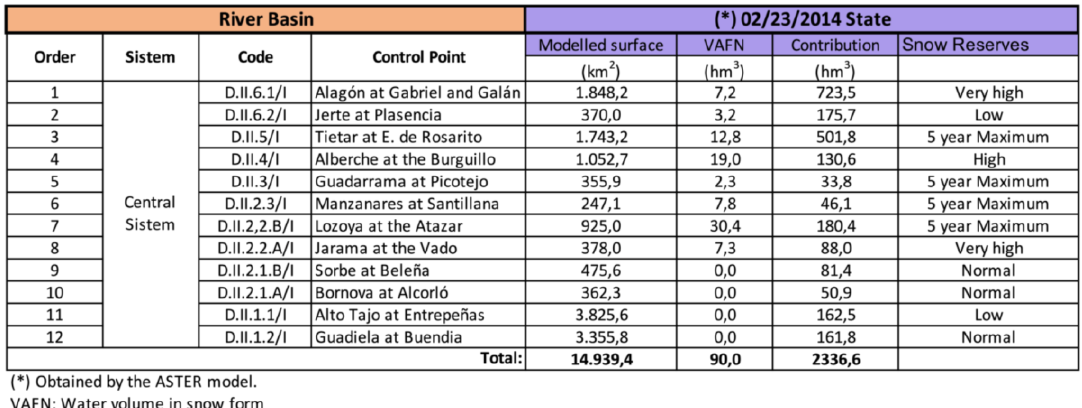
Water 2020 , 12 , x FOR PEER REVIEW Figure 5. Exampleofmonthlysnowreport(ERHIN)intheTagusBasin(TagusHydrographicConfederation). Figure 5. Example of monthly snow report (ERHIN) in the Tagus Basin (Tagus Hydrographic Confederation).